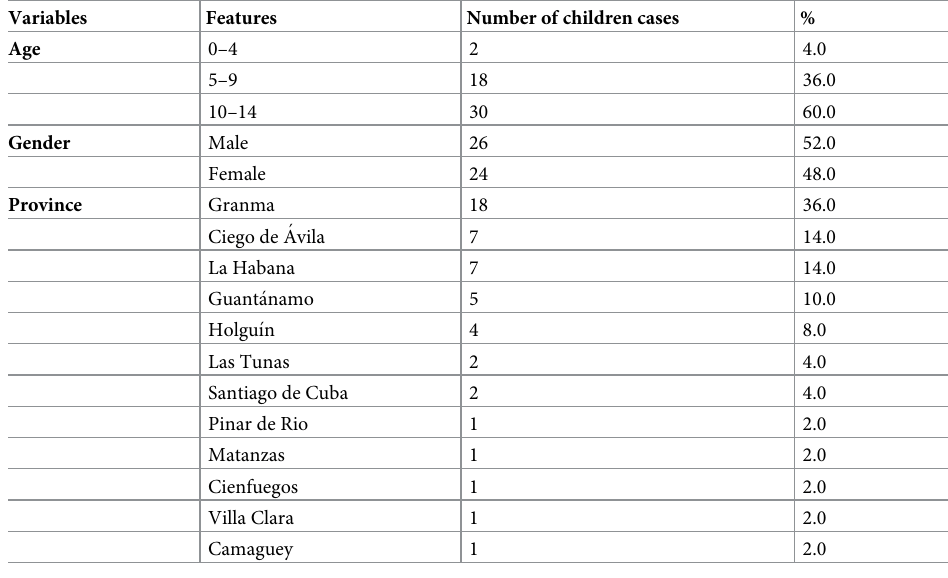
Table 2. Demographics of childhood leprosy (N = 50) � .